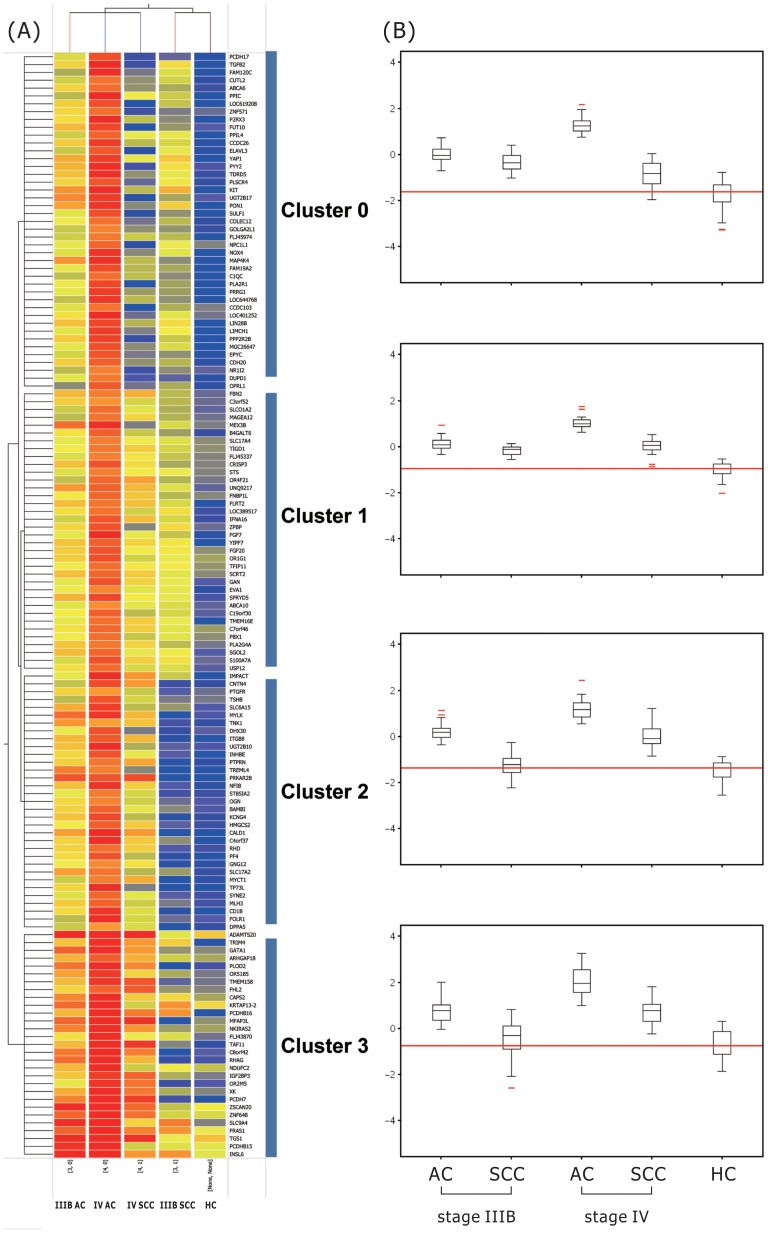
Hierarchical clustering of PBMC samples from patients with advanced stage lung cancer and healthy controls.(A) Hierarchical clustering of patients with newly-diagnosed advanced stage non-small cell lung cancer (n = 30) and healthy controls (n = 20) according to the expression of the 69 genes differentially expressed among stage IIIB adenocarcinoma (AC), stage IV AC, stage IIIB squamous cell carcinoma (SCC), stage IV SCC, and healthy controls (HC). The data are presented in a matrix format: each row represents a gene on the microarray and each column a subgroup of mRNA samples. The ratios of hybridization of fluorescent cDNA probes were a measure of relative gene expression in each experimental sample to a reference mRNA sample, and are depicted according to the following color scale: red indicates a high level of expression; blue, low level of expression; and yellow, mean level of expression. (B) Normalized median gene expression values for cluster 0–3 genes in five subject categories (stage IIIB AC, stage IIIB SCC, stage IV AC, stage IV SCC, HC). Note that cluster 1 genes showed higher expressions in all lung cancer patients compared to the HC. Cluster 0 genes showed similar expressions in stage IV SCC and HC. Both cluster 2 and 3 genes showed similar expressions in stage IIIB SCC and HC. The box plots show the 25th, 50th, and 75th percentiles, maximum, and minimum.